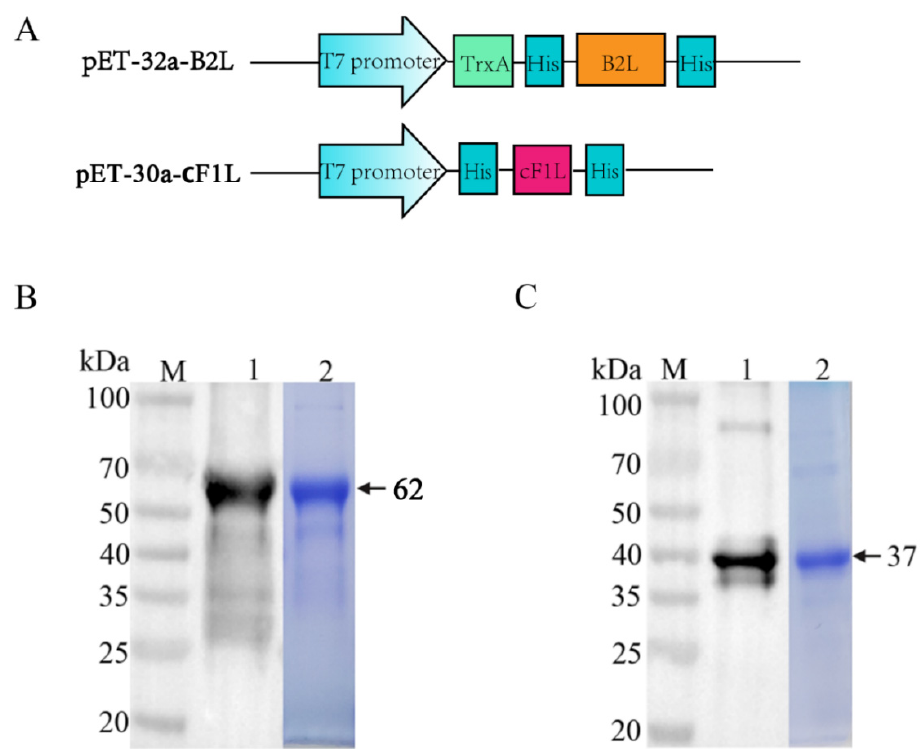
Figure 2. Expression and purification of recombinant B2L and cF1L protein. ( A ) Schematic diagram of the construction of pET-32a-B2L and pET-30a-cF1L. ( B ) Western blotting and SDS-PAGE were used to detect the expression and purification of recombinant B2L protein. Lane 1: identification of the B2L protein expression by Western blotting exploiting mouse anti-B2L protein polyclonal antibodies as primary antibodies; lane 2: the purified recombinant B2L protein was detected by SDS-PAGE. ( C ) Western blotting and SDS-PAGE were used to detect the expression and purification of recombinant c F1L protein. Lane 1: identification of the c F1L protein expression by Western blotting exploiting mouse anti-cF1L protein polyclonal antibodies as primary antibodies; lane 2: the purified recombinant cF1L protein was detected by SDS-PAGE. M: protein molecular weight marker.